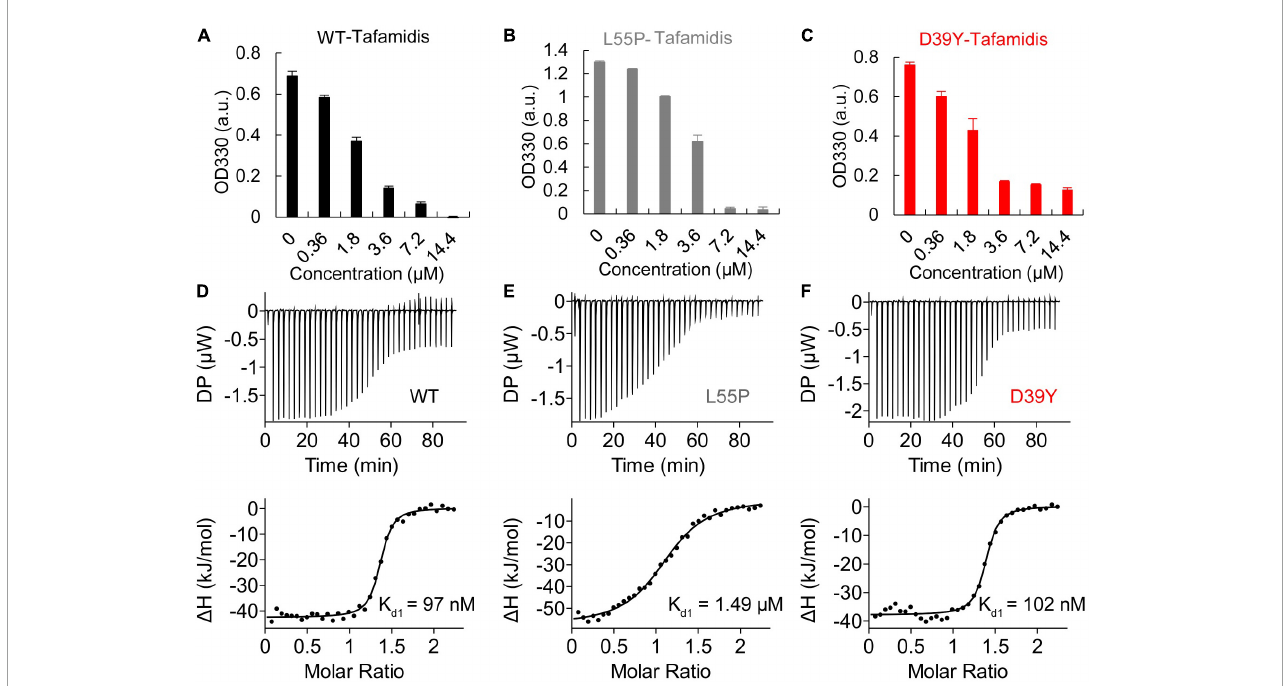
FIGURE5 Inhibitory effect of Tafamidis on TTR amyloid formation. (A) WT (B) L55P (C) D39Y (3.6 µ M) were incubated with increasing concentration of Tafamidis in acidic aggregation buffer (200 mM NaOAc, 100 mM KCl, acidified by AcOH to pH = 4.4) for 72 h. OD330 turbidity assay was used to monitor the formation of TTR amyloid. Isothermal titration calorimetry (ITC) of Tafamidis with wild type (D) , L55P (E) and D39Y (F) TTR revealed the dissociation constant of Tafamidis with TTR. TTR concentrations were 300 µ